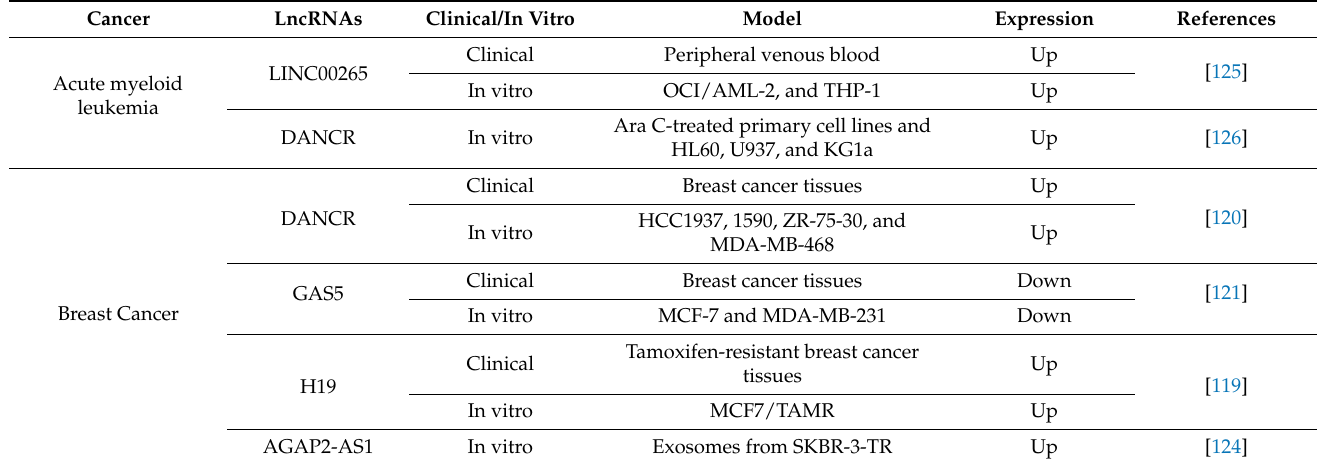
Table 1. Different autophagy-modulating lncRNAs and their expression in various cancers.